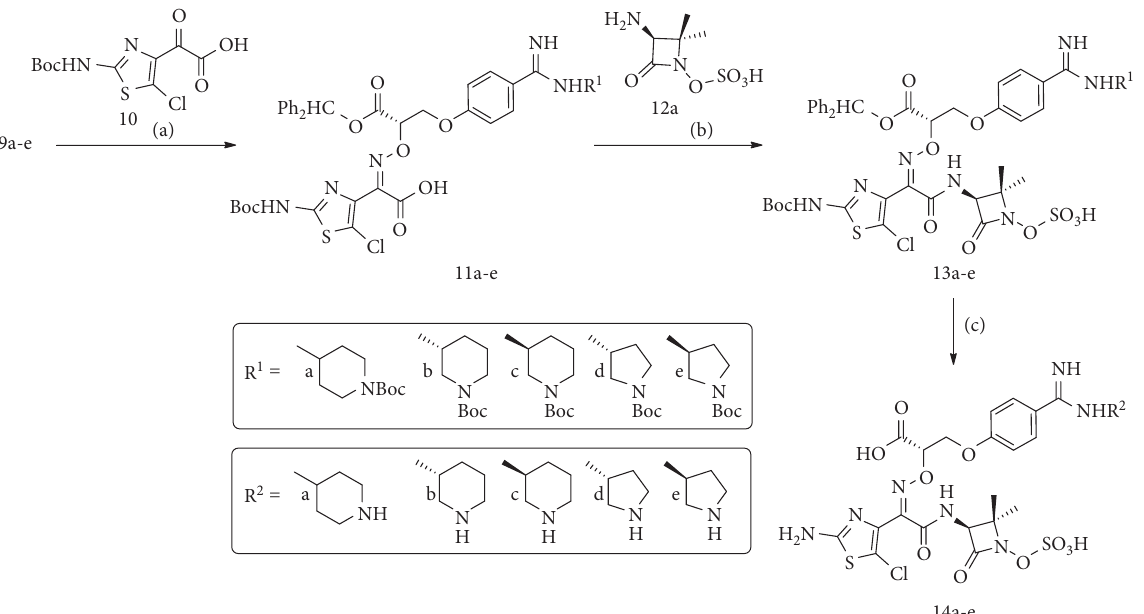
Scheme 2: Synthesis of compounds 14a – e. Reagents and conditions: (a) 10 , EtOH-CHCl DMF, 0 ° C – rt, 41–88%; (c) TFA, CH 2 Cl 2 , 0 ° C – rt, 7–15%.